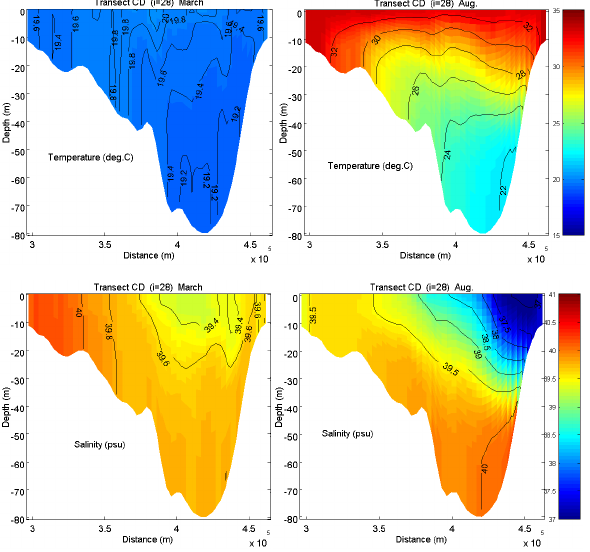
Fig. 10. Cross-section of the mean temperature and salinity along CD path, shown in Fig. 5 obtained from model simulation during March (left) and August (right).